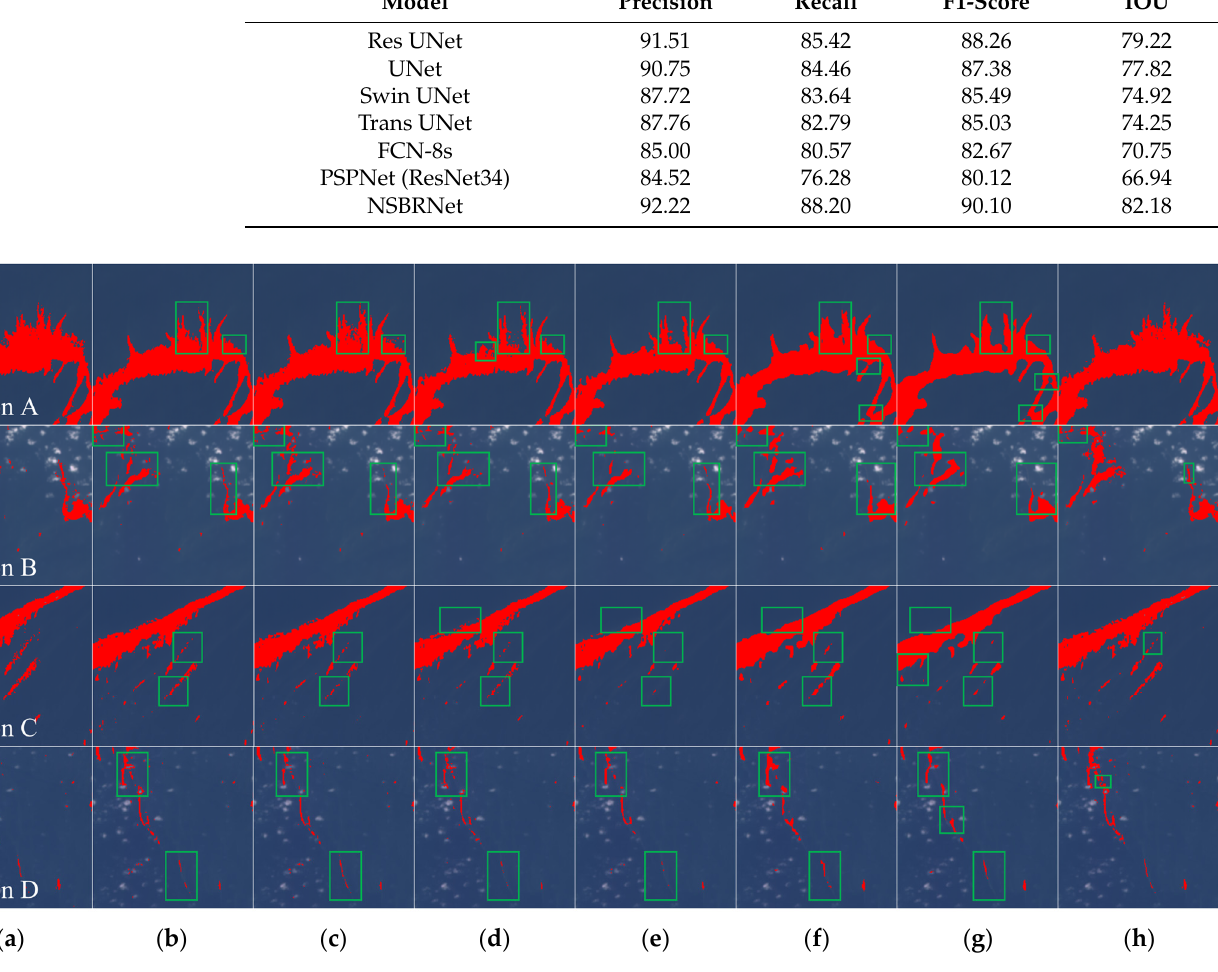
Figure 13. In fl uence of each model on the performance of NSB recognition. ( a ) FRGB; ( b ) ground truth; ( c ) UNet; ( d ) NSBRNet (SAB); ( e ) NSBRNet (ICB); ( f ) NSBRNet. Green frames are locations where the di ff erences between model recognized and the ground truth are larger.